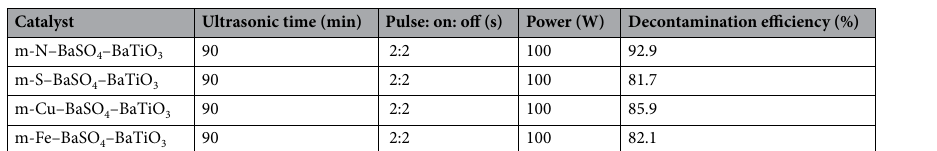
Table 4. Effect of sucrose on piezocatalytic activity of doped BaTiO 3 to degrade AR151.